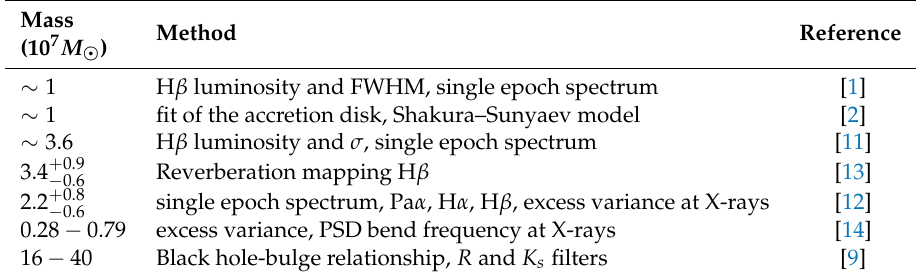
Table 1. Summary of the mass estimates of the central black hole in J0324 +